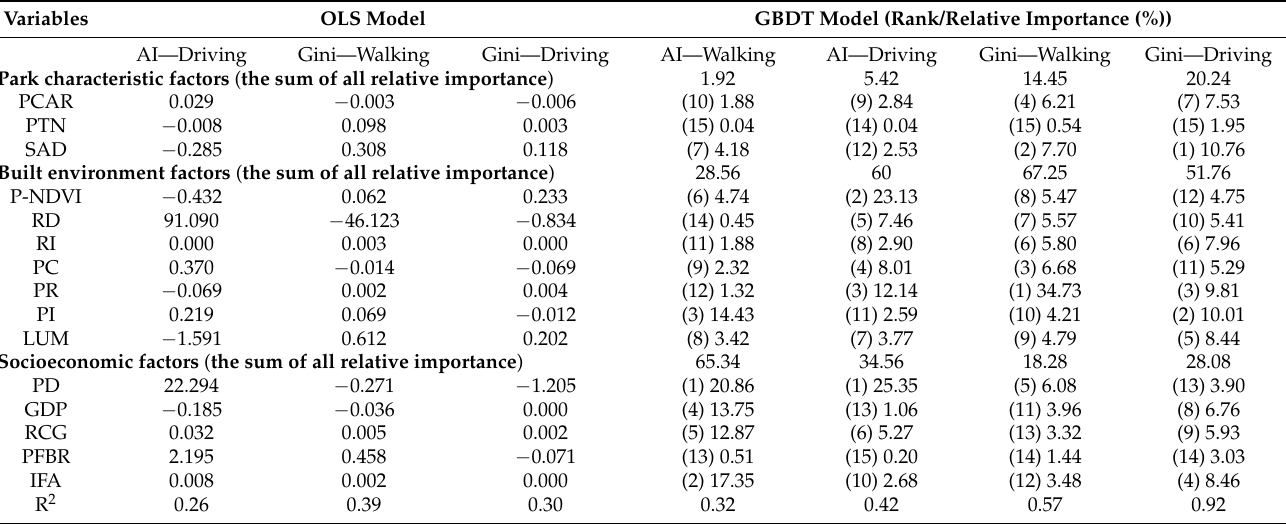
Table 3. Relative importance of three categories of influencing factors on the service equity of PGSs